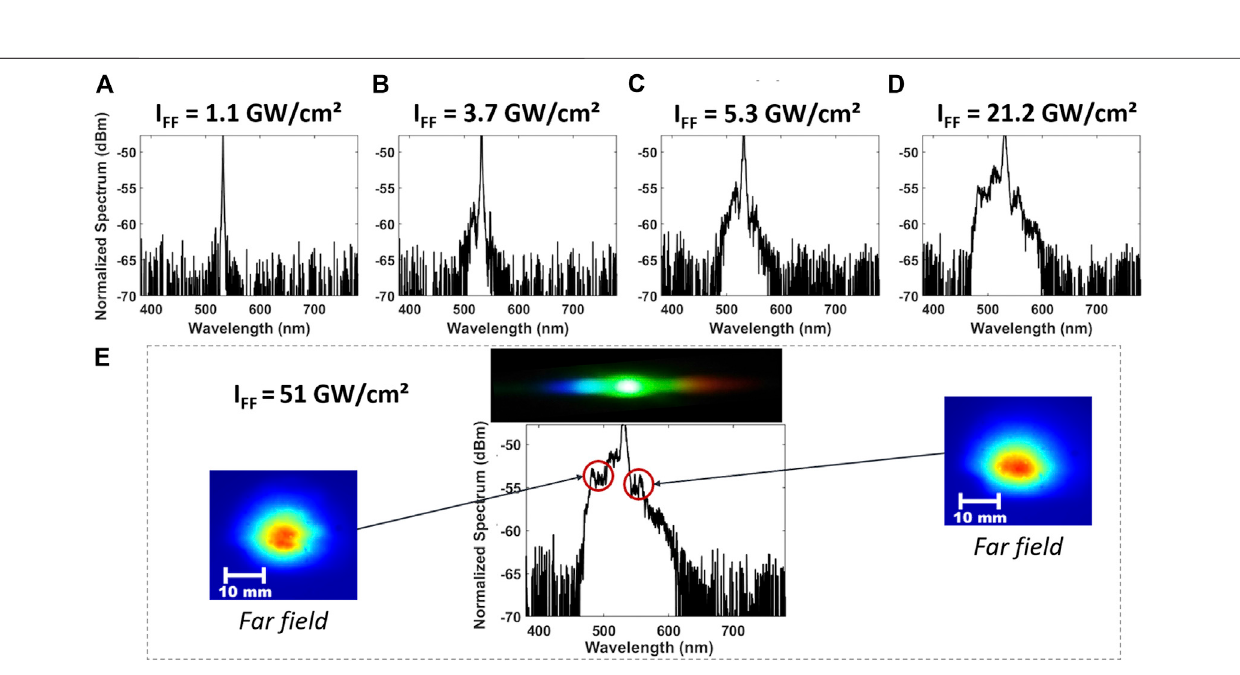
FIGURE6|(A ) – (D) — spectralevolutionoftheSHbeamfordifferentinputpumpintensities. (E) — spectrumoftheSHbeamatI FF (cid:1) 51 GW/cm 2 withcorresponding photographic image. The two insets show the far- fi eld beam shape of the two selected spectral components at 500 nm (left) and 550 nm (right), respectively.